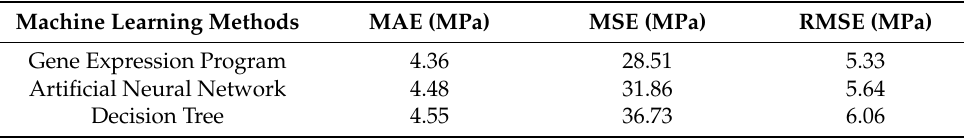
Table 5. Statistical